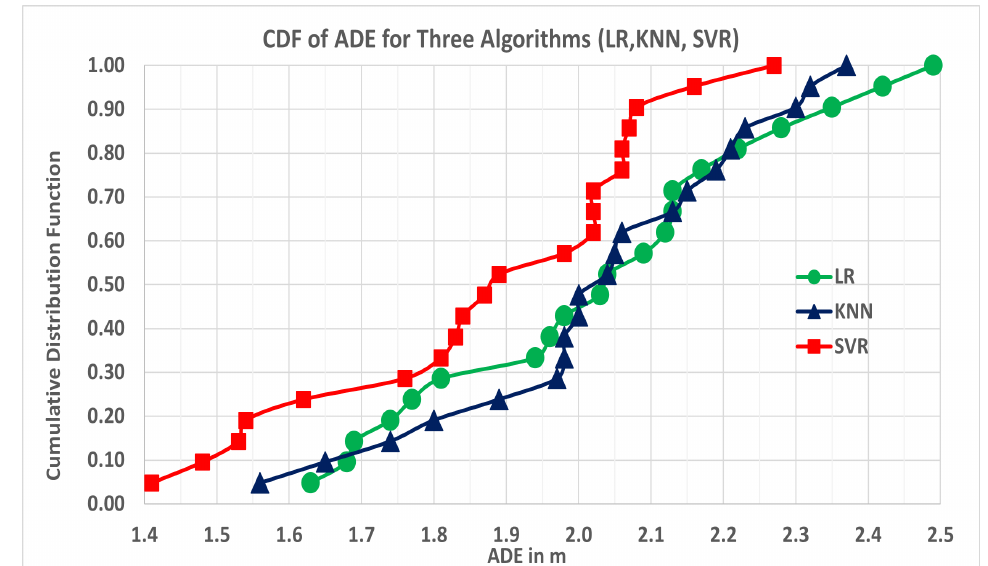
Figure 6. Cumulative Distribution Function (CDF) of